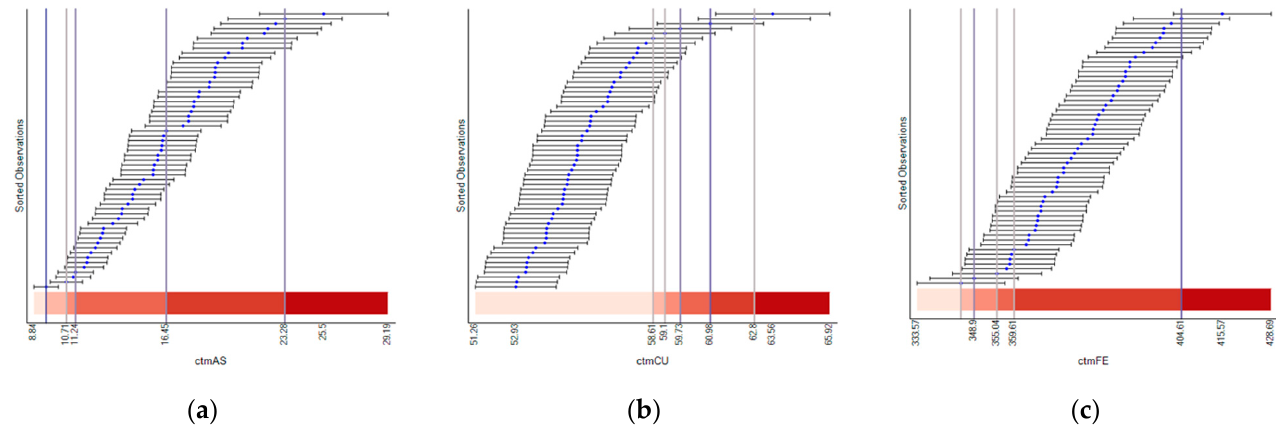
Figure 4. Illustrative heavy metals classification results for assay error and their corresponding theoretical analytical measurement error: ( a ) As, ( b ) Cu, and ( c ) Fe.